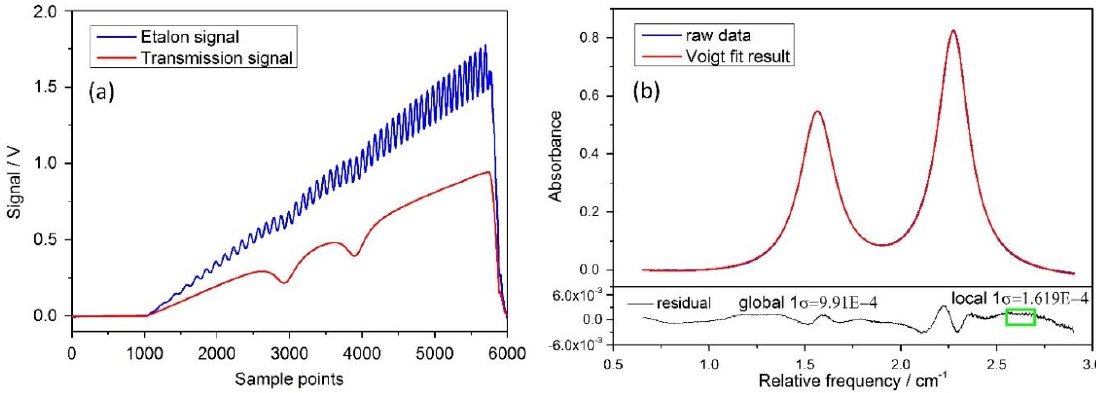
Figure 6. ( a ) A measurement example of etalon interference signal and water vapor absorption signal; ( b ) Water vapor absorption spectrum and multi-peak Voigt profile fit and fitting residual. Global 1 σ indicates the standard deviation of the residuals in the whole spectral window, while local 1 σ corresponds to the standard deviation of the residuals within the rectangle.